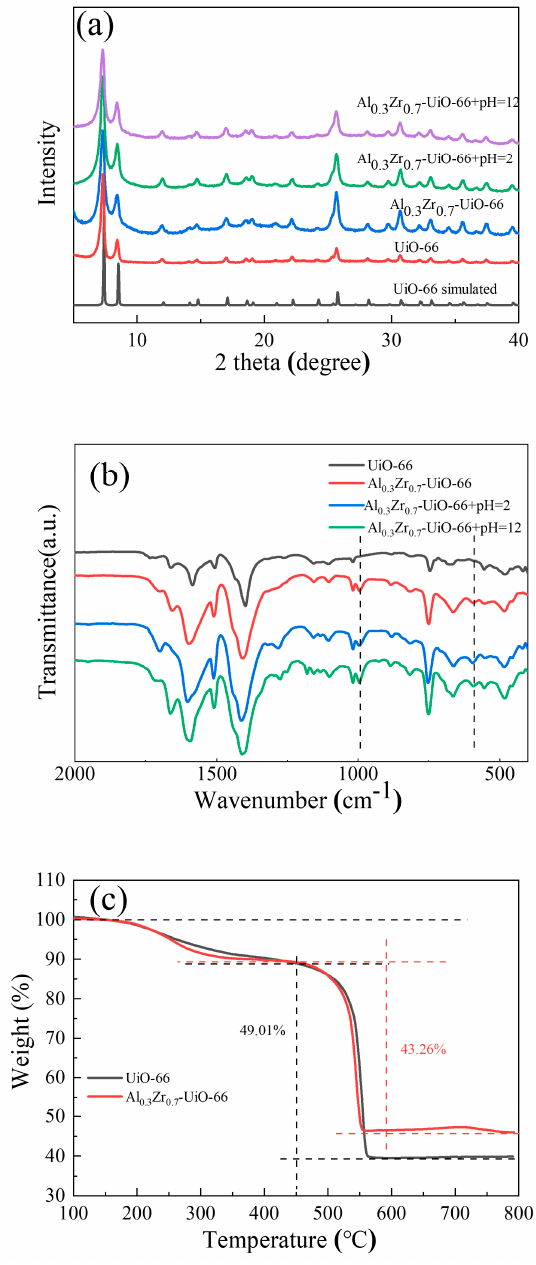
Figure 5. ( a ) XRD patterns, ( b ) FTIR spectra of Al 0.3 Zr 0.7 -UiO-66 before and after exposure to aqueous solutions at pH = 2 and pH = 12, and ( c ) TGA curves of UiO-66 and Al 0.3 Zr 0.7 -UiO-66.